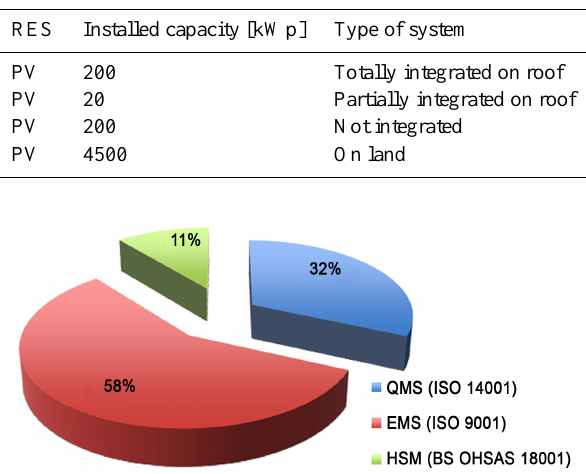
Table 10. Type and capacity of RES systems installed in the Alta Val d’Agri industrial area (data from direct survey).